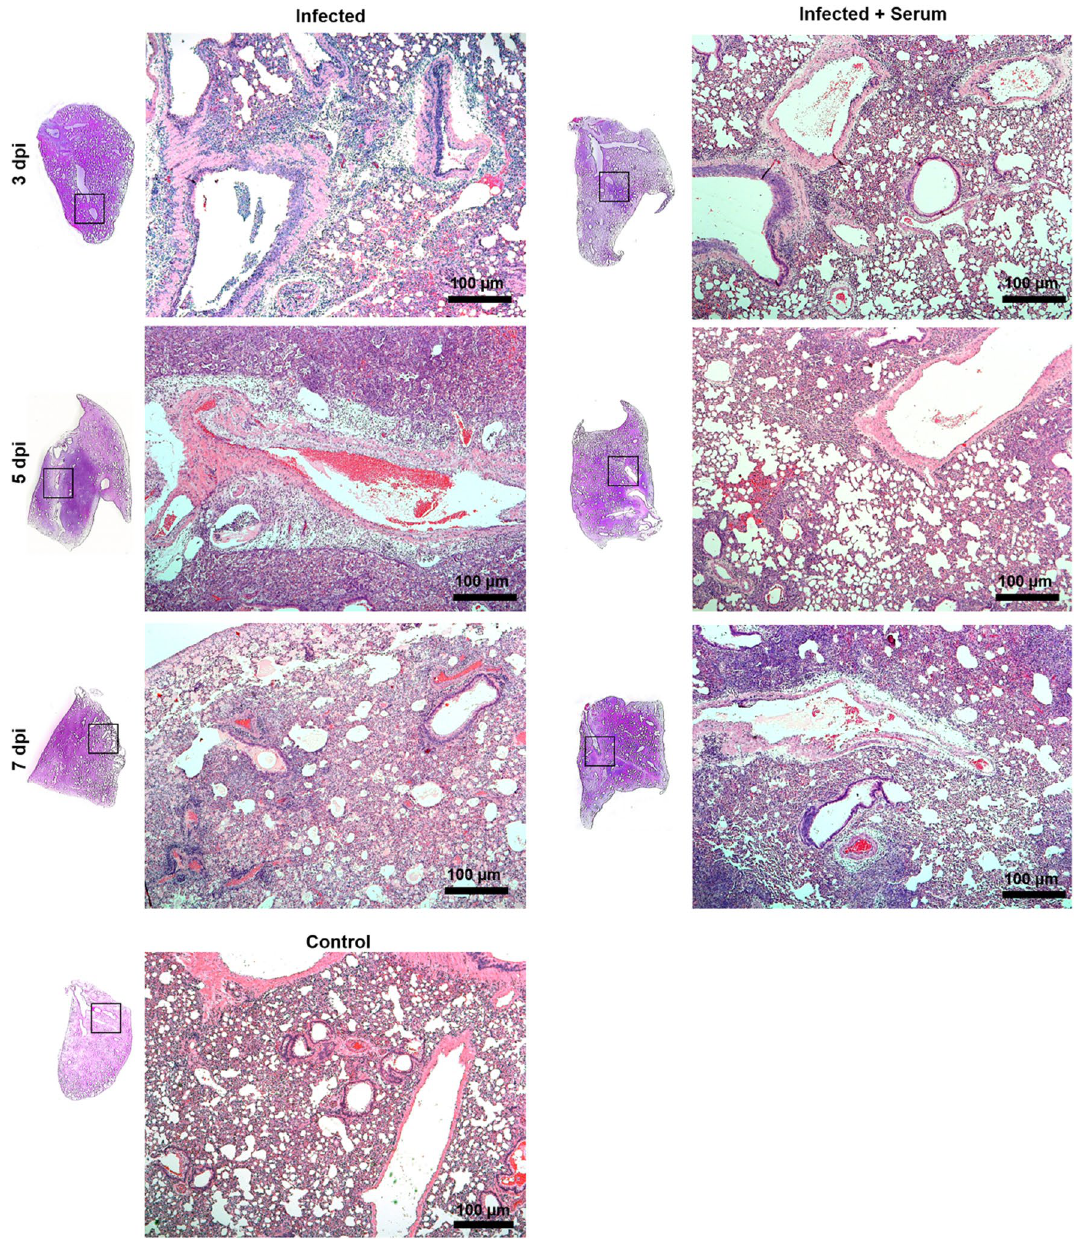
Figure 4. The pneumonic pattern of animals infected and treated with equine anti-SARS-CoV-2 F(ab ′ ) 2 immunoglobulin. Panels show the evolution of the infectious process in the course of SARS-CoV-2 hamster experimental infection and treatment with equine serum. Infected and nontreated animals showed a more marked evolution of the diffuse interstitial pneumonia pattern, mainly on Day 7 after infection, than infected and SARS-CoV-2-treated animals. Control samples show the normal histological pattern of the tissue. Bar 100 µm; haematoxylin and eosin staining